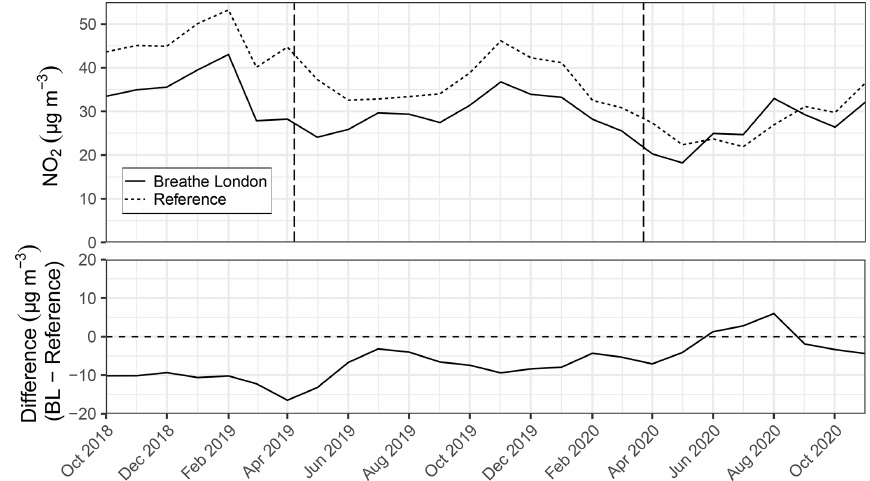
Figure 4. Comparison of monthly mean NO 2 concentrations for the BL ( n = 100) and London reference ( n = 105) networks. Bottom panel shows difference between networks. Vertical lines denote Ultra Low Emission Zone (ULEZ) start date (8 April 2019) and the start of the first Covid-19 lockdowns (23 March 2020).